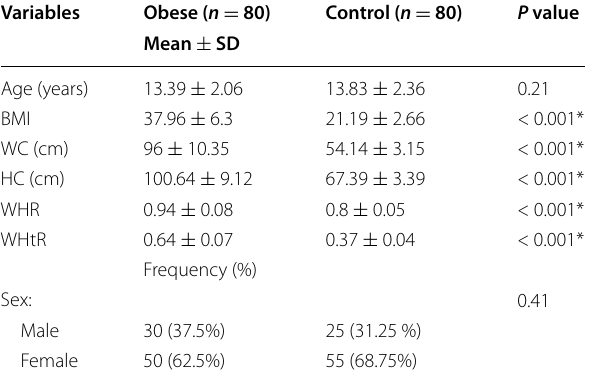
Table 1 Demographic and clinical data of the study groups